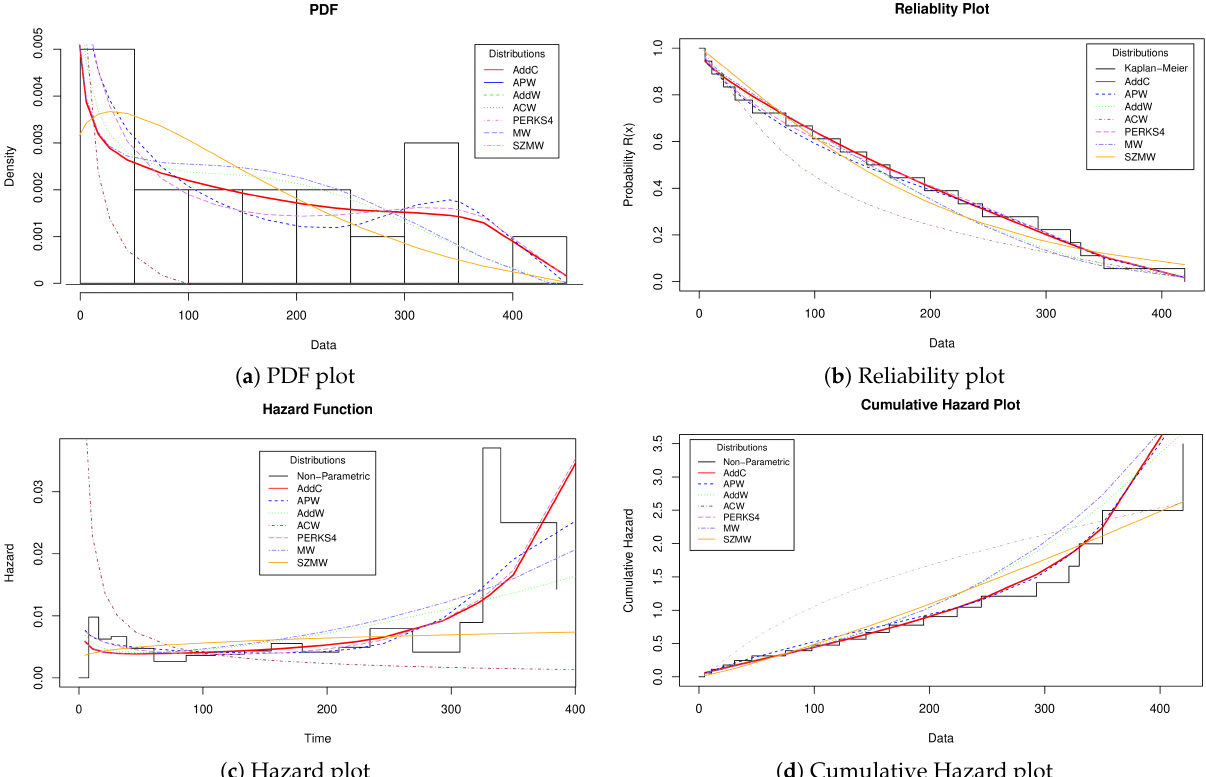
Figure 8. Reliability Plots for Lifetime data presented in Table